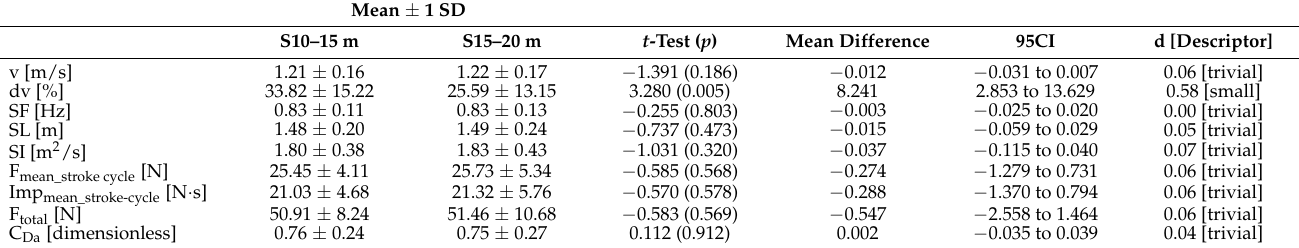
Table 2. Descriptive data (mean ± one standard deviation—1SD) of all variables measured and the t -test comparison between sections.